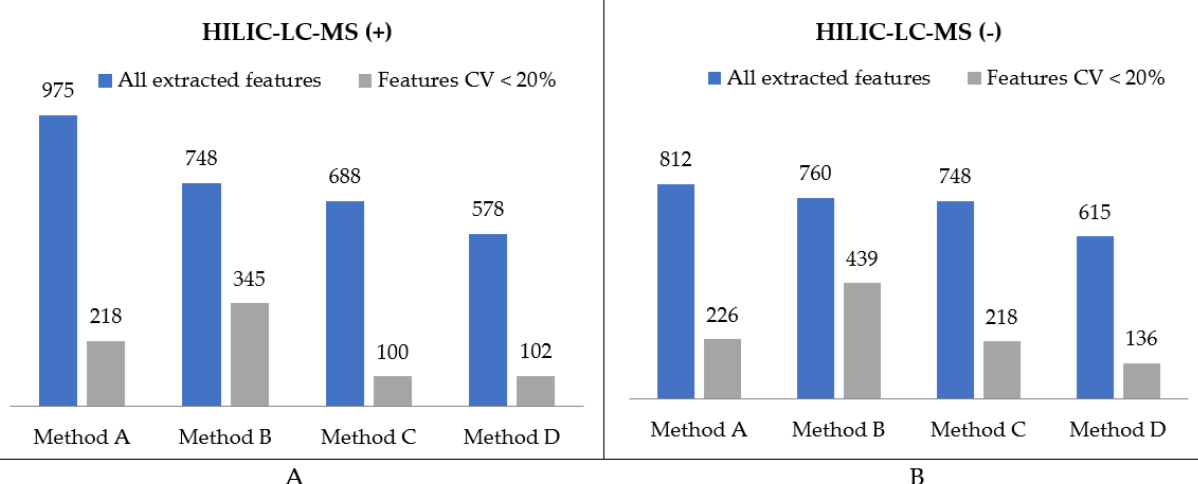
Figure 5. UpSet plots presenting the overlap between the compared extraction methods in terms of lipid compounds detected in ( A ) positive and ( B ) negative ionization modes.